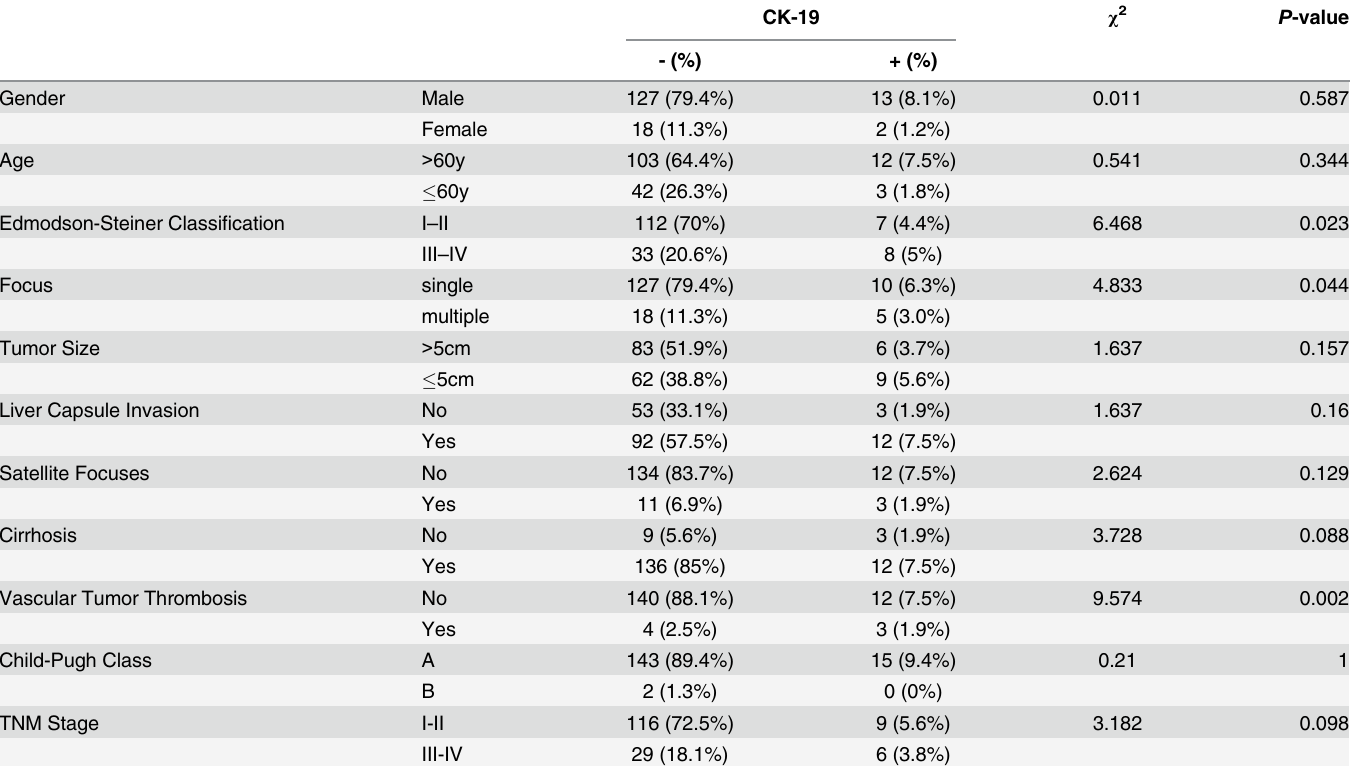
Table 2. Relationships between CK-19 expression and clinicopathological parameters in patients with an AFP concentration of < 400 μ g/L ( n =